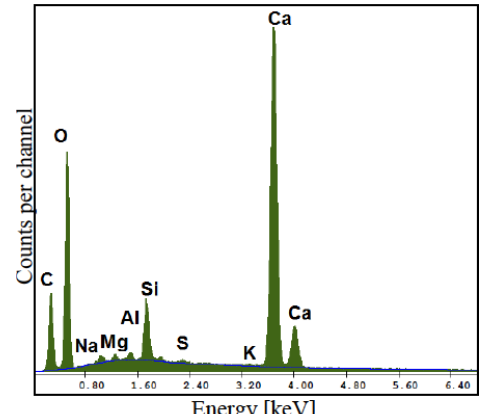
Figure 7: Sample after compressive strength test.